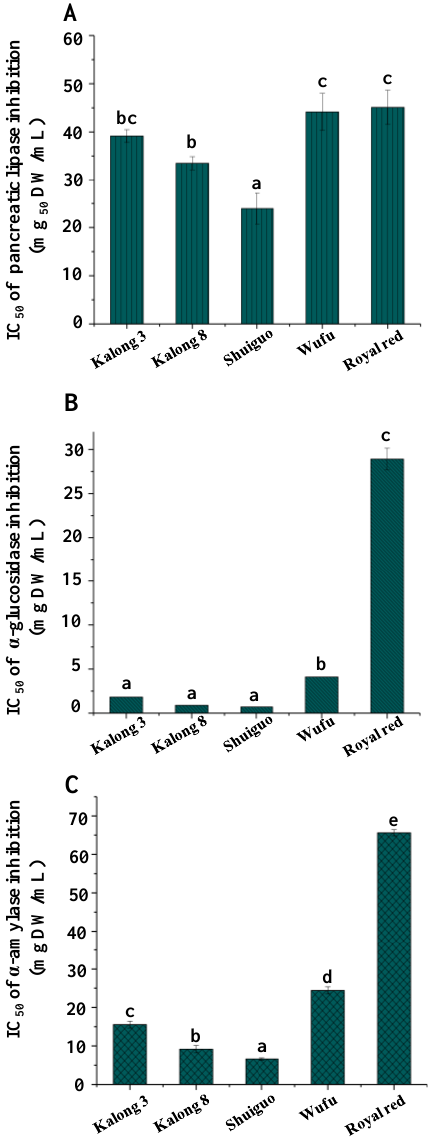
Figure 2. Inhibitory effects on pancreatic lipase ( A ), α -glucosidase ( B ), and α -amylase ( C ) of different cultivars of okra fruits; significant ( p < 0.05) differences are shown by data bearing different letters (a – e).